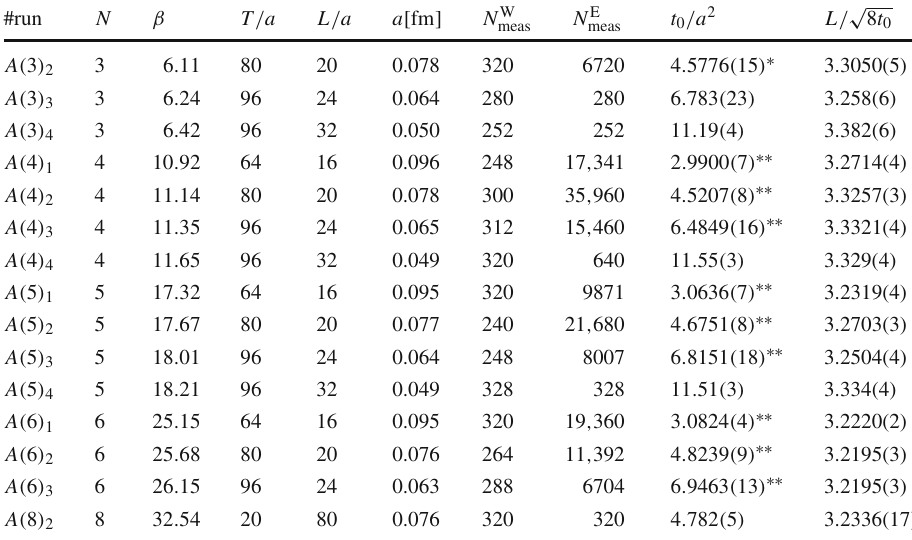
Table 1 Parameters of the simulations. For each of the gauge groups SU ( N ) we give the inverse lattice coupling β = 2 N 2 /λ 0 , the dimensions of the lattice, the approximate lattice spacing using √ t 0 = 0 . 166fm followed by the number N W meas of measurements used for the computation of the smooth Wilson loops, and N E meas for the action density, Eq. (2.4). In the second to last column we present the values of t 0 / a 2 : ∗ taken from Ref. [53] and ∗∗ taken from Ref.